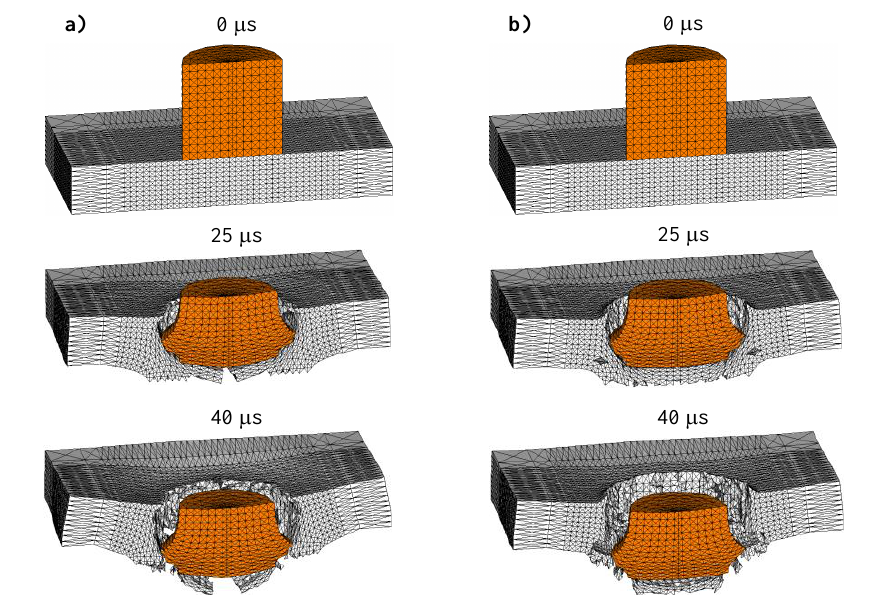
Fig. 4. FEM-based simulation results of interaction of the Ni 3 Al plate with the steel punch, when the hardening of the Ni 3 Al alloy is defined by a) monotonically increasing  dependence, b) non- monotonic  dependence.